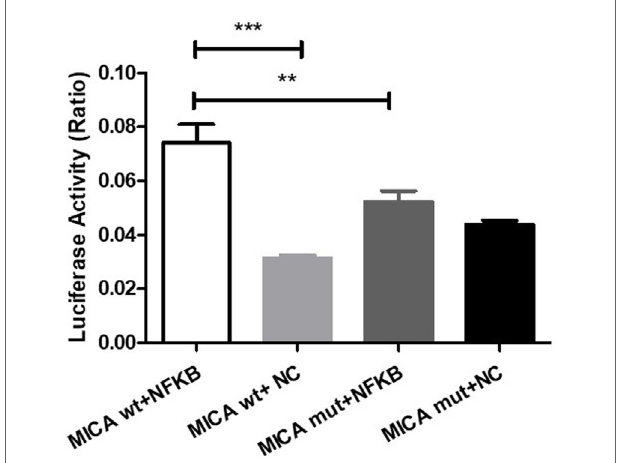
FigUre 7 | NF κ B action on the MICA promoter region. Luciferase reporter assay of 293 T cells transfected with pGL4.10-MICA promoter-WT or pGL4.10-MICA promoter-mutant together with cDNA3.1-NF κ B-3Flag or NC. ** p < 0.01; *** p < 0.001. WT, wild type; mut, mutant; NC, negative control; ns, not significant.